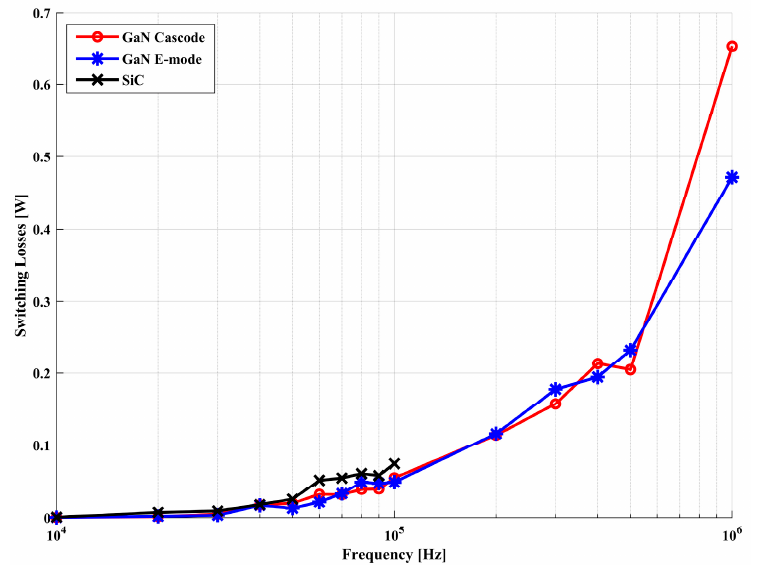
Figure 16. Power switching losses vs. frequency.